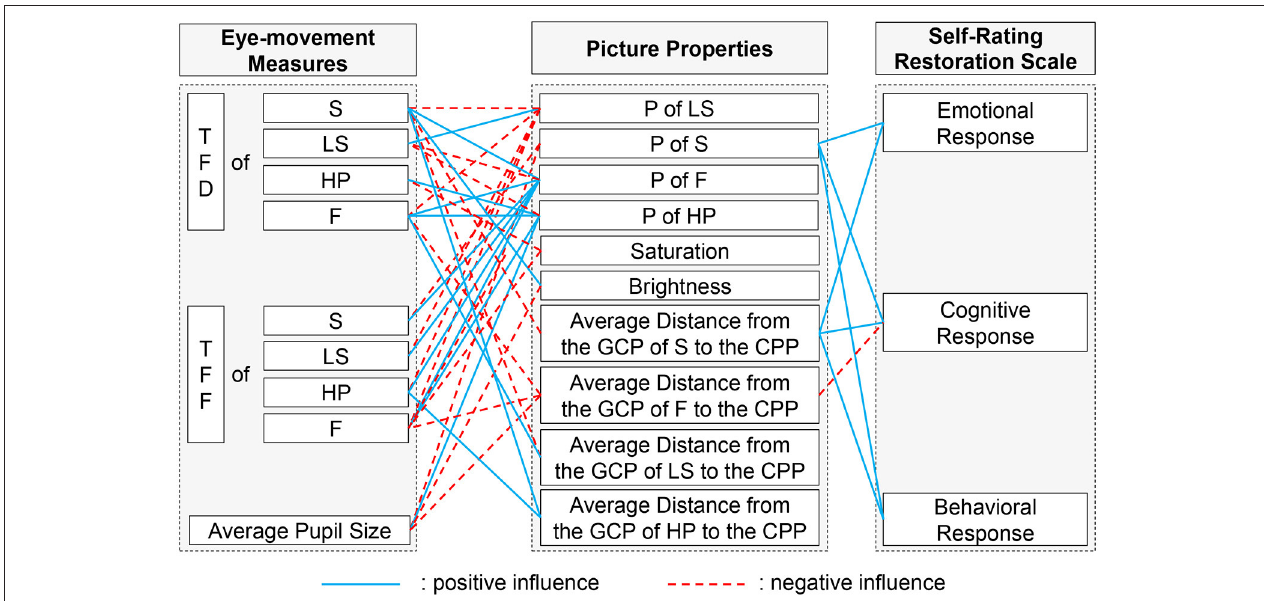
FIGURE 3 | Relationship between the proportion of picture properties and EMM and SRRS score. TFD, Total Fixation Duration; TFF, Time to First Fixation; P, Proportion; S, Sky Element; F, Facade Element; LS, Landscape Space Element; HP, Hard Paving Element; GCP, Geometrical Center Point; CPP, Center Point of the